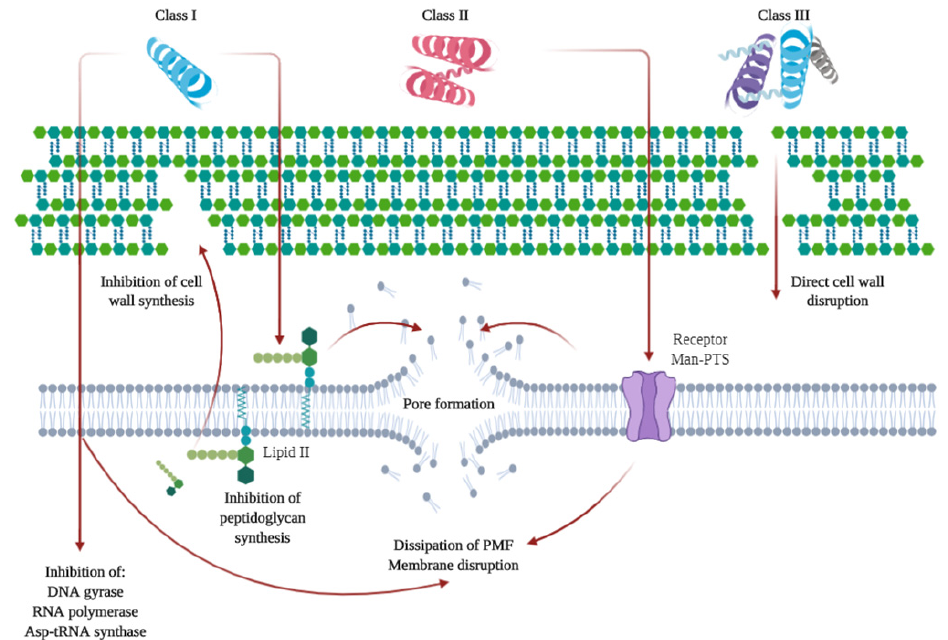
Figure 3. Summary of the mechanisms of action of class I, II, and III bacteriocins. Class I can directly penetrate cell membranes and a ff ect cell integrity using di ff erent inhibition pathways. It can bind to lipid II, causing the inhibition of peptidoglycan synthesis and thus, disrupting cell wall formation or inducing pore formation that leads to cell death. In the case of Class II, they can penetrate cell walls and bind to mannose phosphotransferase (Man-PTS) receptors initiating a process of pore formation, as well as penetrate cell membranes and a ff ect cell content by disruption of the proton motive force, among other activities. Class III can act directly on cell walls causing their disruption. Based on References